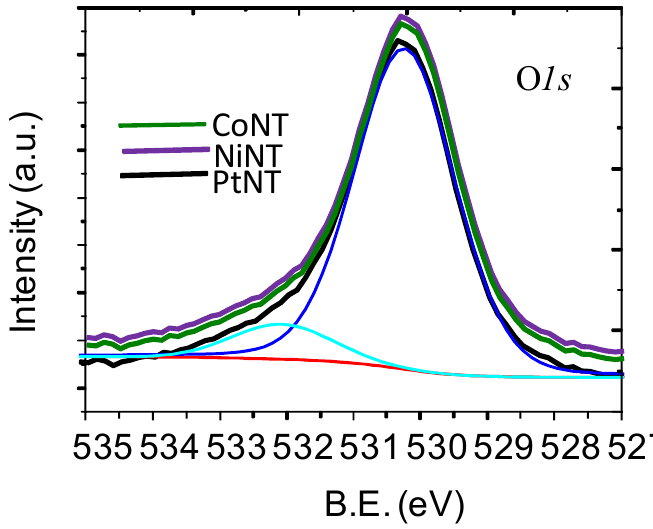
Figure A2. O 1 s core level XPS spectra for fresh titanate nanotubes.